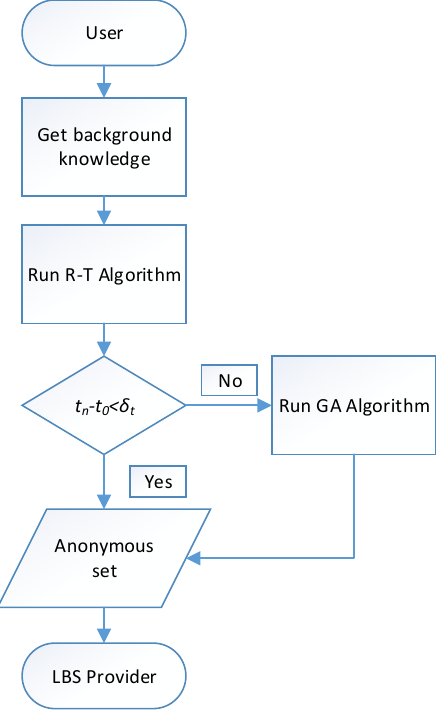
Figure 5. The workflow of our algorithm based on road